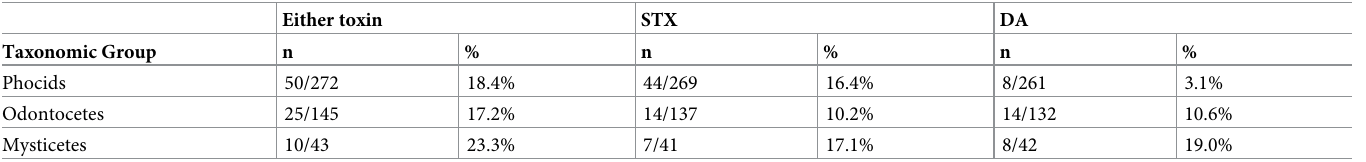
Table 4. Toxin detection frequencies by taxonomic group.